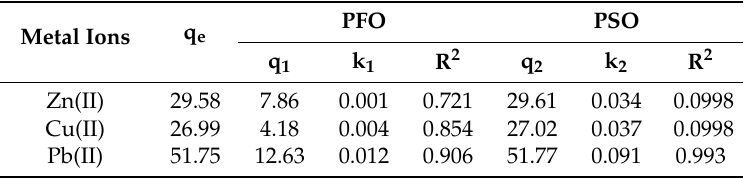
Table 7. Parameters of the kinetic models for the adsorption of Zn(II), Cu(II), Pb(II) ions on composite